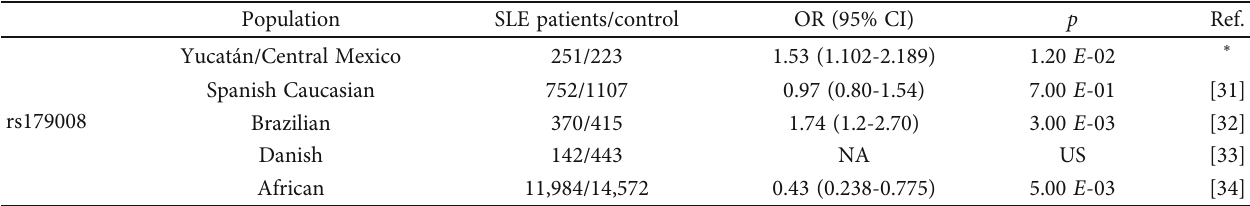
Table 4: Studies on rs179008 of TLR7 associated with SLE in Mexico and other populations. Population SLE